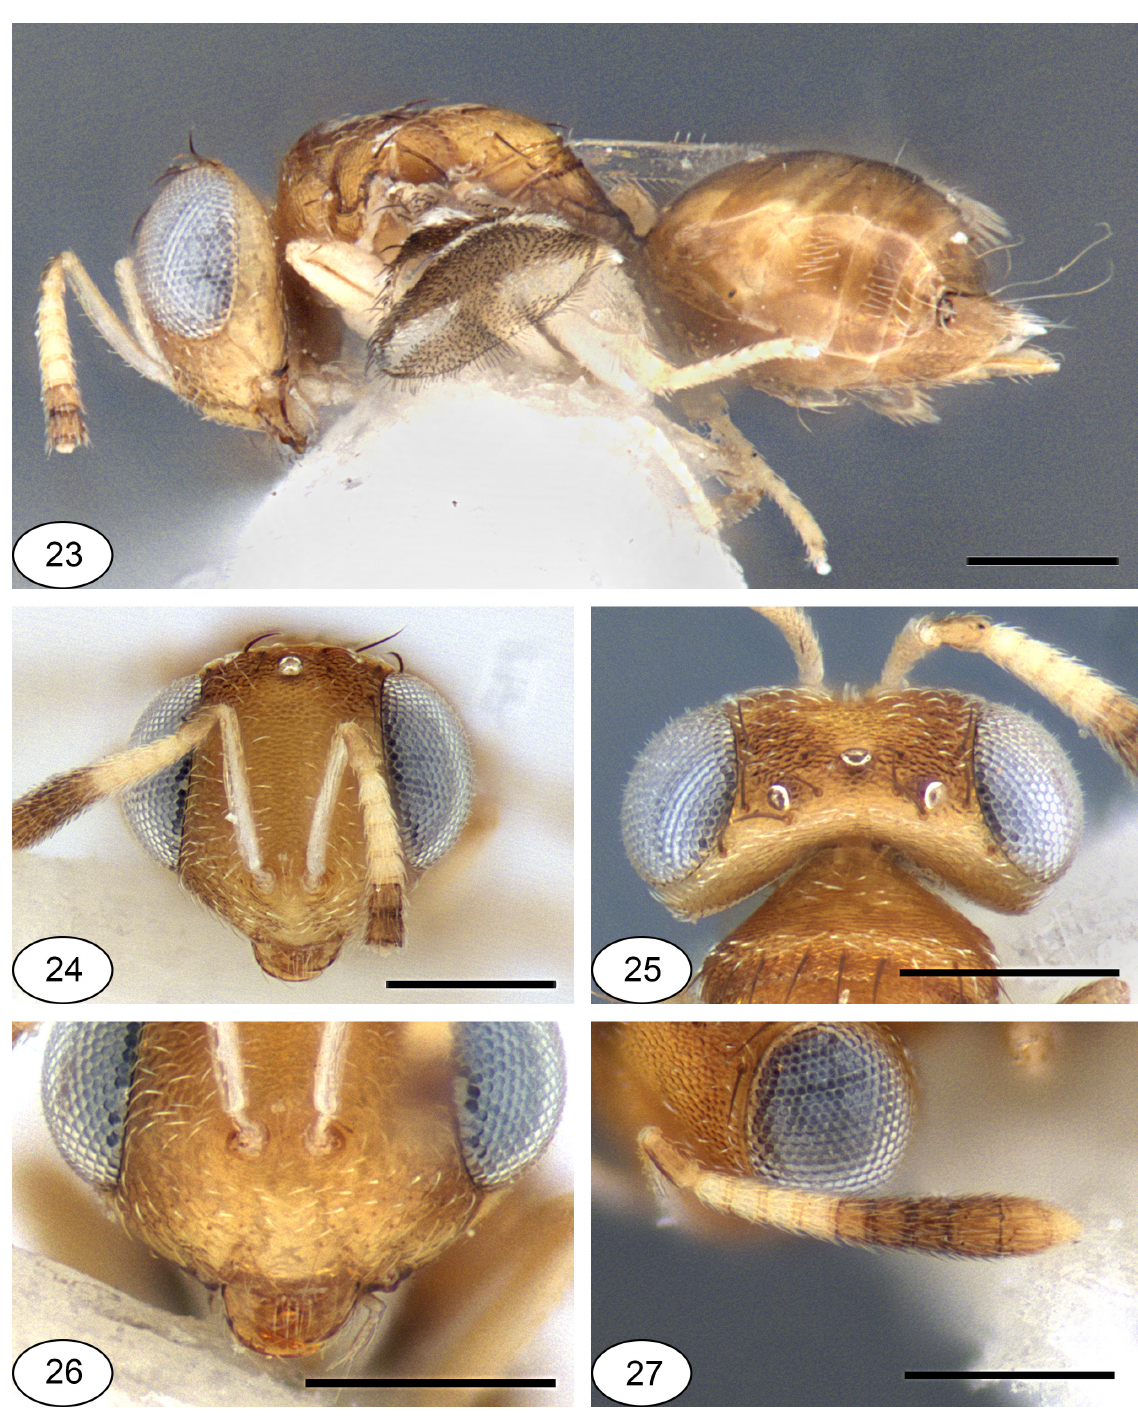
Figs 23–27. Netomocera amethysta sp. nov., holotype, ♀. 23 . Habitus, lateral view. 24 . Head, frontal view. 25 . Head, dorsal view. 26 . Lower face. 27 . Antenna. Scale bars: 0.2